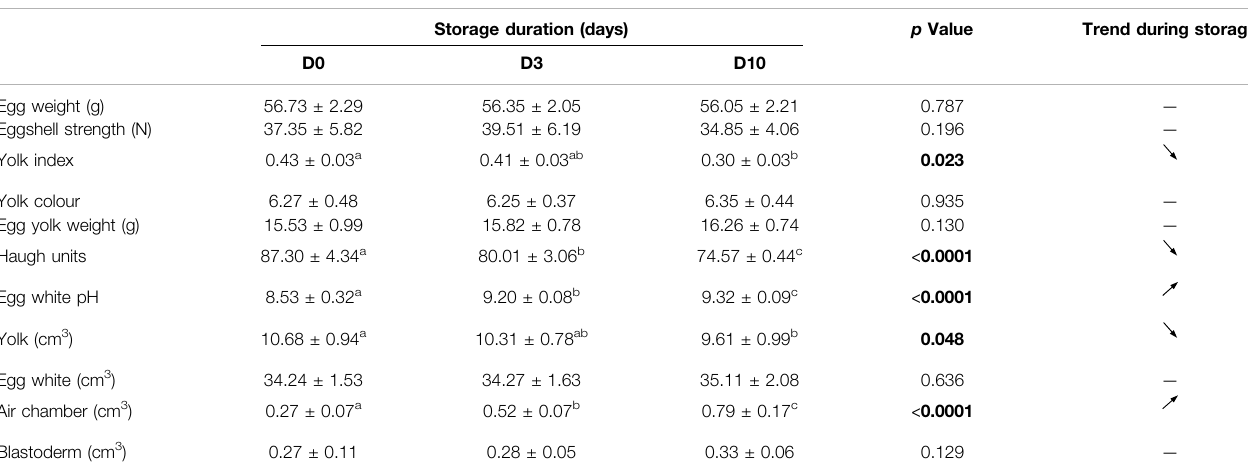
TABLE 2 | Effect of egg storage on egg parameters.